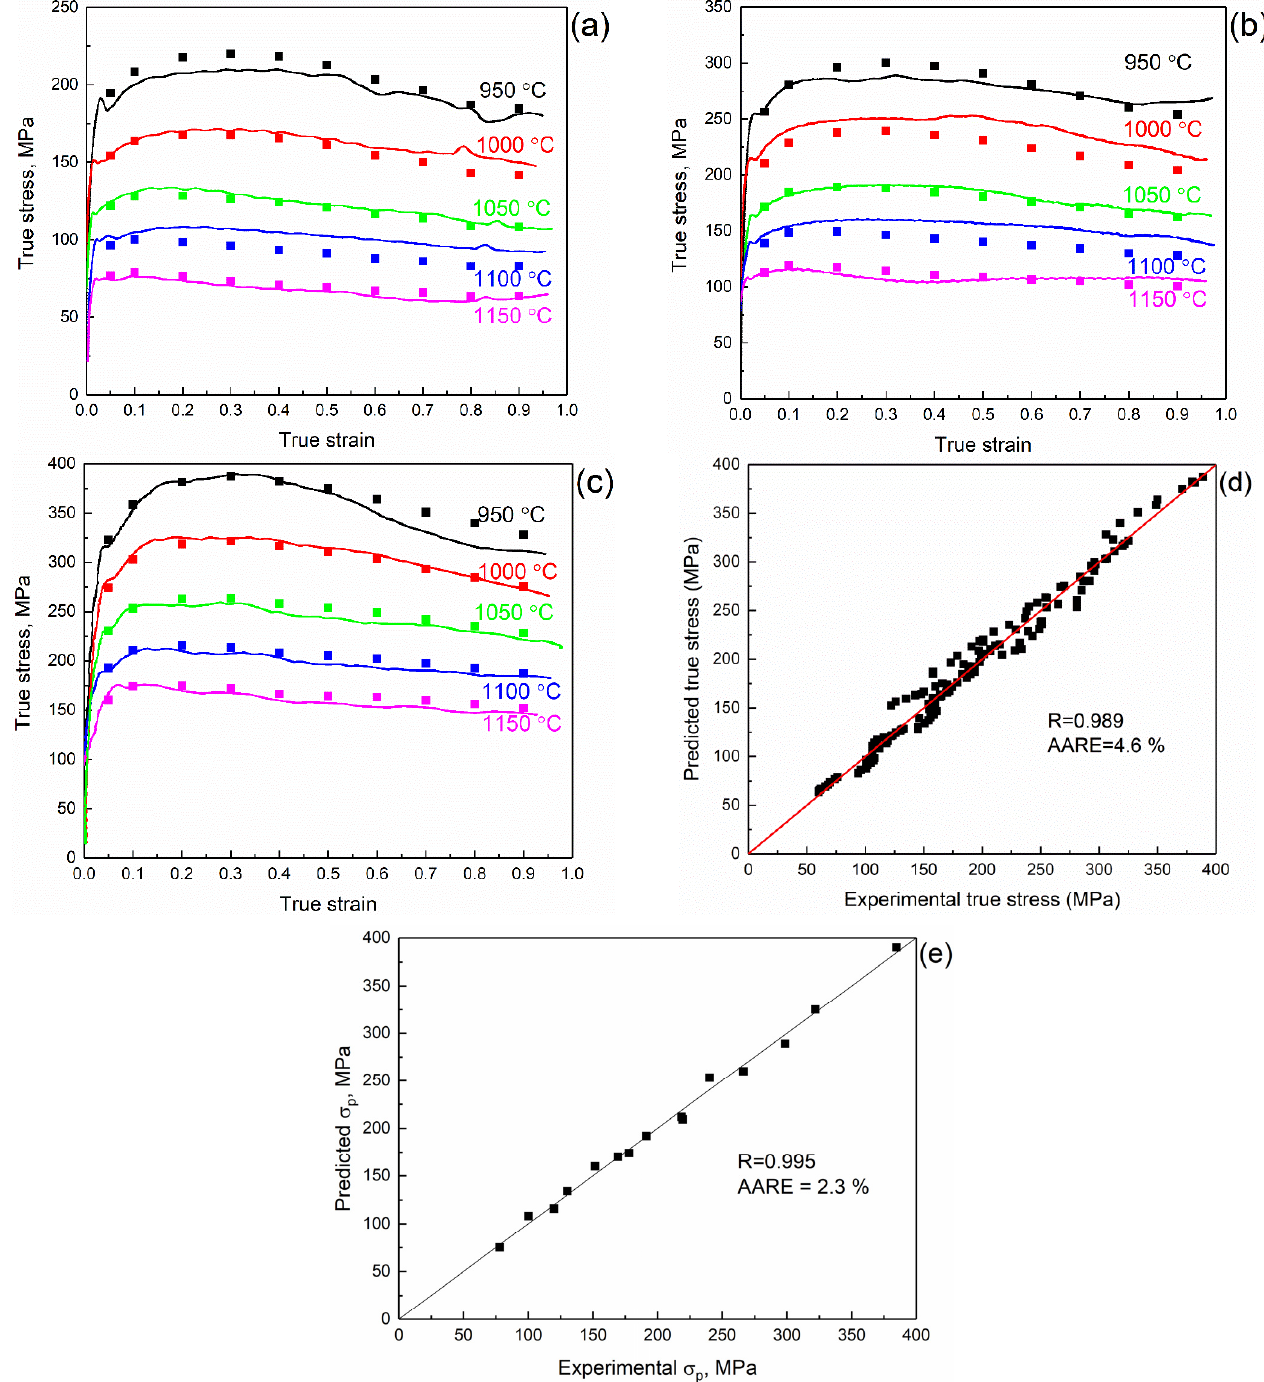
Figure 6. A comparison between the experimental and predicted true stress for the Fe-35Mn-10Al-1C steel at a strain rate of 0.1 s − 1 ( a ), 1 s − 1 ( b ), 10 s − 1 ( c ), for the whole dataset ( d ) and for peak stress values ( e ).